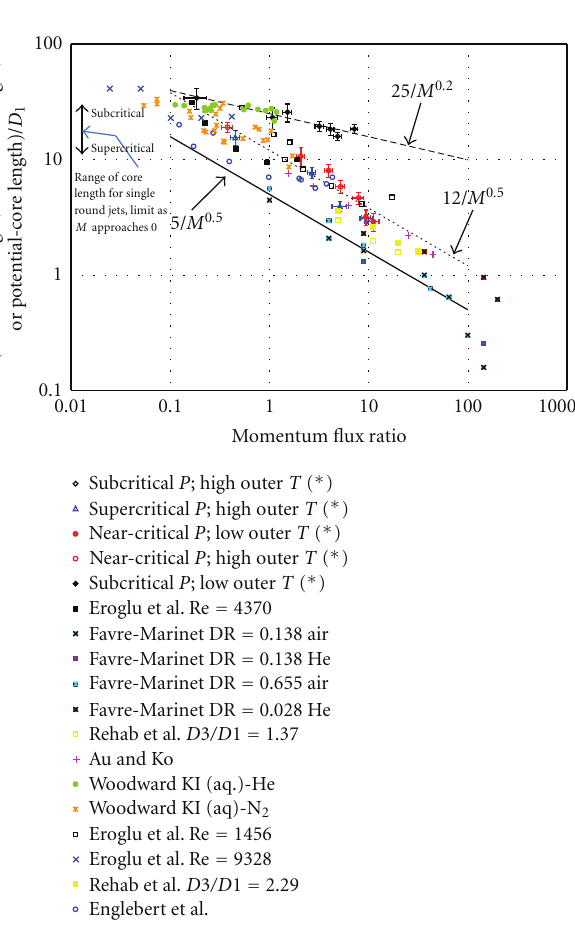
Figure 22: This figure shows comparison of the present coaxial- jet dark-core length measurements with all other relevant core length data available in the literature versus momentum flux ratio. Amongst the data reported by others, Eroglu et al. [47], Englebert et al. [48], and Woodward [50] are two-phase flows and the rest are single phase. The range of core length for cryogenic single jet (LN 2 /GN 2 ) is also shown at the left margin. Davis and Chehroudi [42,